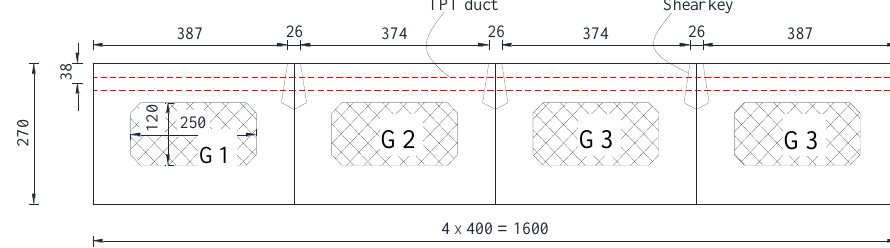
Figure 1. Geometry of bridge model (dimensions in mm).